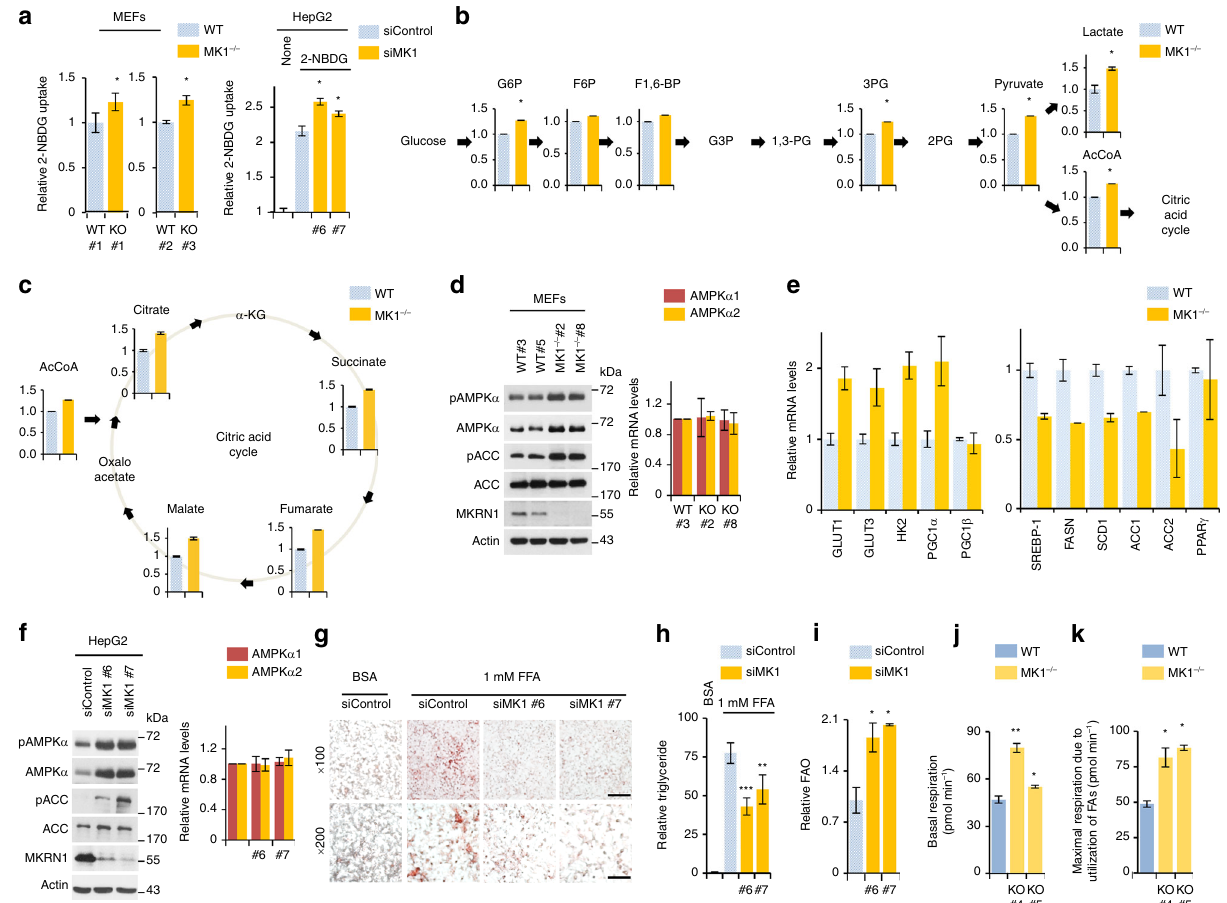
Fig. 1 MKRN1 depletion stimulates glucose metabolism by activating AMPK signalling. Analysis of wild-type (WT) or MKRN1 -knockout ( MK1 − / − ) littermate primary mouse embryonic fi broblasts (MEFs) and HepG2 cells transduced with two independent siRNAs targeting MKRN1 (siMK1 #6 and siMK1 #7) or a control siRNA for 48 h. a Glucose consumption in MK1 − / − MEFs (left) or MKRN1-depleted HepG2 cells (right) was measured based on the absorption of 2-[ N -(7-nitrobenz-2-oxa-1,3-diazol-4-yl) amino]-2-deoxy- D -glucose (2-NBDG) by the cells. b , c Intracellular levels of glycolytic and citric acid cycle intermediates were determined by capillary electrophoresis – time-of- fl ight mass spectrometry of the MEFs. Each bar represents the relative amount of a metabolite for WT MEFs. G6P glucose-6-phosphate, F6P fructose-6-phosphate, F1,6-BP fructose-1,6-bisphosphate, G3P glucose-3-phosphate, 1,3-BG 1,3-bisphosphoglycerate, 3PG 3-phosphoglycerate, 2PG 2-phosphoglycerate, AcCoA acetyl-CoA, α -KG α -ketoglutarate. d , f To validate the AMPK signalling pathway or mRNA levels of AMPK α subunits, immunoblotting or quantitative real-time PCR analysis was performed using MEFs ( d ) and HepG2 cells ( f ). Cell lysates were immunoblotted with antibodies against pAMPK α , AMPK α , pACC, ACC, MKRN1 and actin. e The mRNA levels of glycolytic or lipogenic enzymes in MEFs were analysed by quantitative real-time PCR. g , h FFA-induced steatosis in HepG2 cells. Oil Red O staining ( g ) and TG levels (scale bar = 100 µ m (top), 50 µ m (bottom) ( h ) of the cells treated with FFA/FFA-free bovine serum albumin (BSA), which served as controls. All the experiments with MEFs were conducted in cells within the fi rst 3 – 6 passages. i Fatty acid oxidation was analysed in MKRN1-depleted HepG2 cells. j The basal oxygen consumption rate (OCR) was measured in WT and MK1 − / − MEFs. k After sequential treatment with oligomycin, FCCP and rotenone/ antimycin-A in the presence of BSA or BSA conjugated to palmitate, OCR was measured in WT or MK1 − / − MEFs. The results were normalised against total protein levels using XF-Analyze. All data are presented as the mean ± standard deviation (s.d.) of triplicate samples and are representative of at least three independent experiments. two-tailed Student ’ s t -test; * P ≤ 0.05, ** P ≤ 0.01, *** P ≤